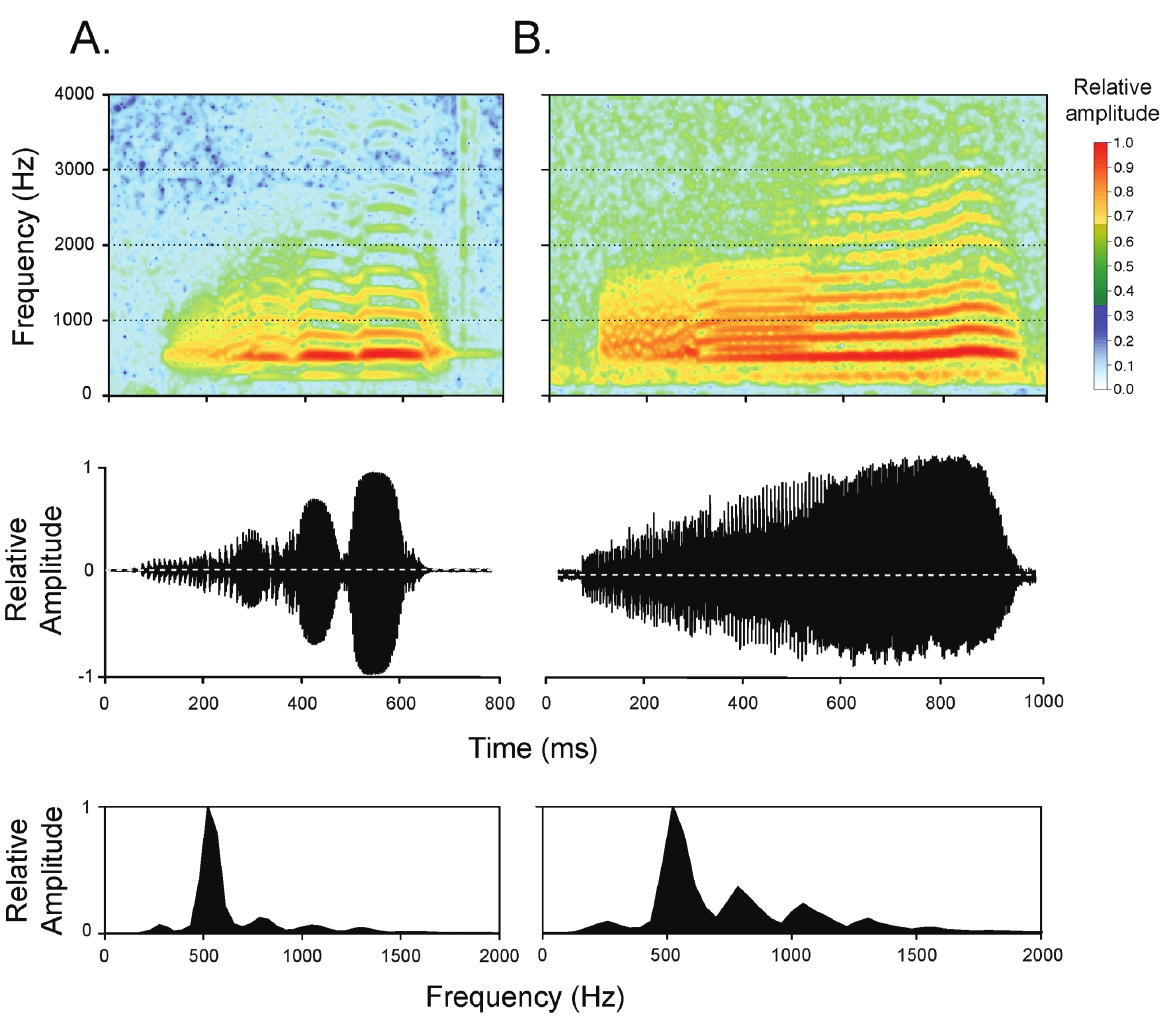
Figure 5. Comparative spectrograms (top), oscillograms (center) and power spectra (bottom) between the calls of ( A ) Rhombo- phryne nilevina sp. n. and ( B ) R. testudo (from Vences et al. 2006). Spectrogram was created using a Hanning window size of